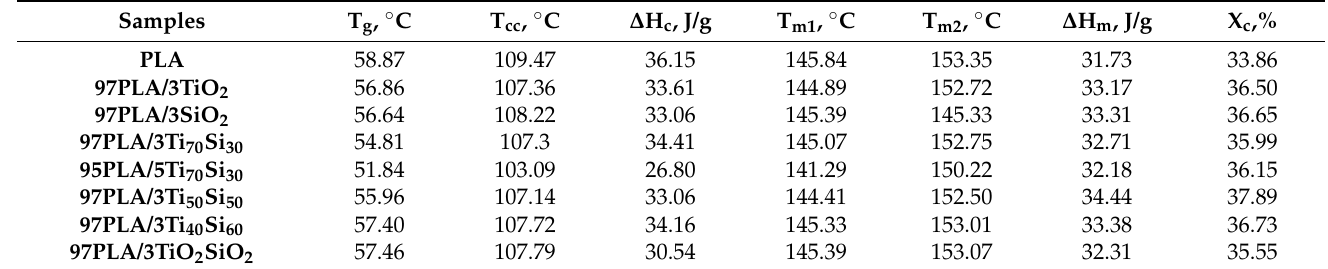
Table 2. Thermal characteristics of PLA, PLA/TiO 2 , PLA/SiO 2 , PLA/Ti x Si y , and PLA/TiO 2 SiO 2 composites (the second heating, heating rate 5 ◦